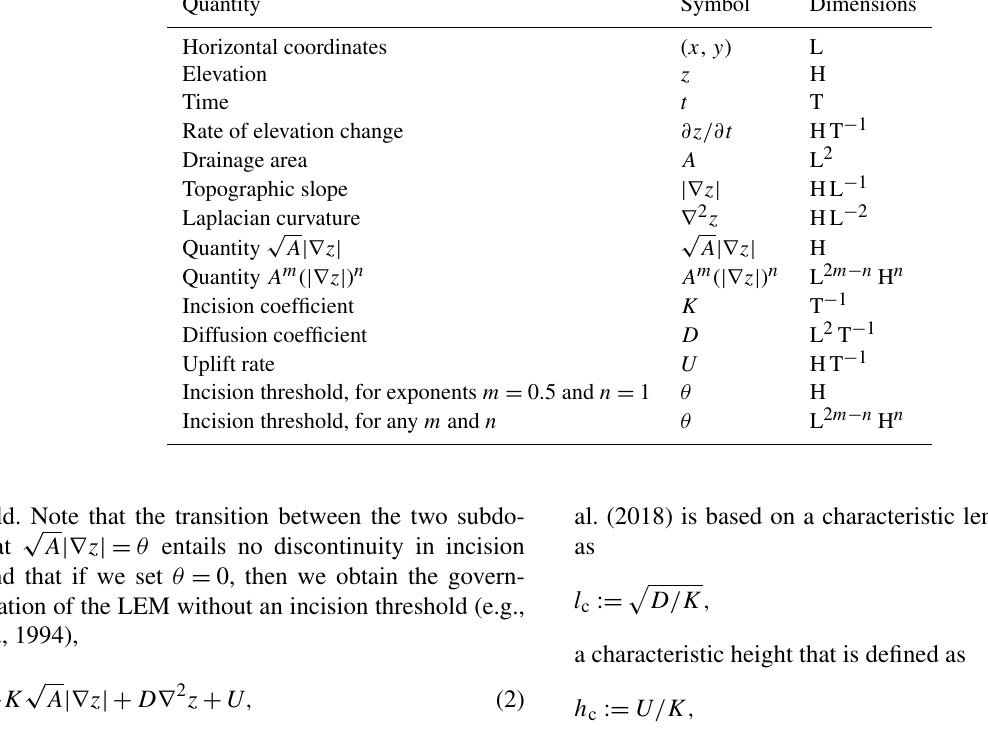
Table 1. Dimensions of the variables and parameters of the LEM. Quantity Symbol Dimensions Horizontal coordinates ( x , y ) L Elevation z H Time Rate of elevation change Drainage area Topographic